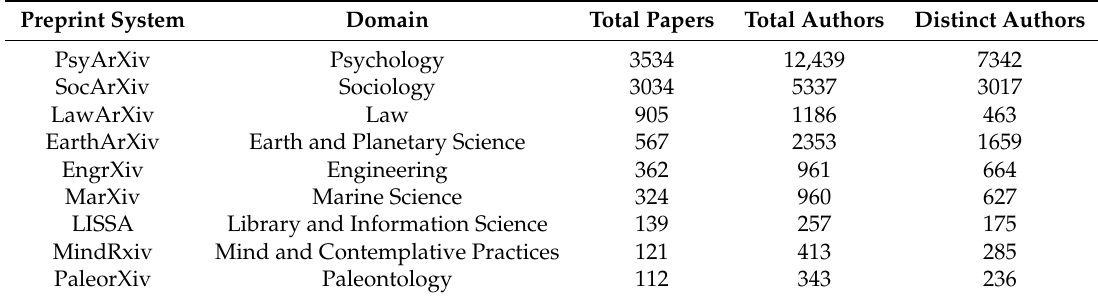
Table 1. Paper and Author counts for 9 COS preprint